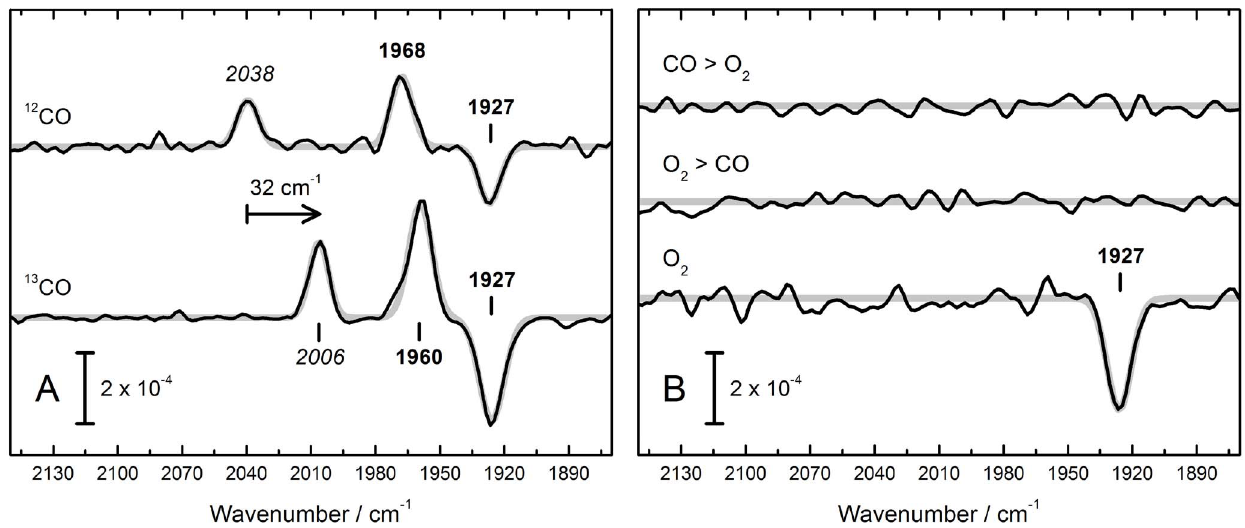
Figure 4. IR difference spectra of HypCD MC that show the effect of 12 CO, 13 CO, and O 2 . (Fig. 4A) Binding of external 12 CO ( 13 CO) produces a new peak, 2038 cm 2 1 (2006 cm 2 1 ) and induces a shift of the original Fe–CO peak from 1927 to 1968 cm 2 1 (1960 cm 2 1 ). Note these spectra do not give rise to difference signals in the CN 2 region. (Fig. 4B) A strong negative contribution at 1927 cm 2 1 is observed. Double difference spectra depict on the influence of O 2 on CO–soaked sample (CO . O 2 ) and vice versa (O 2 . CO). No additional difference bands are observed. Note these spectra do not give rise to difference signals in the CN 2 region.